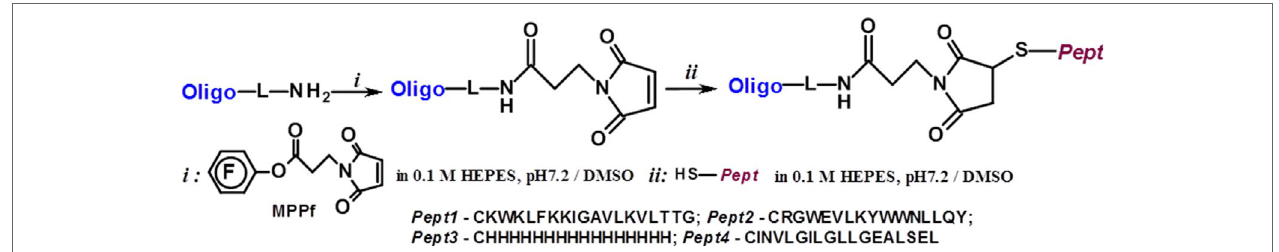
FIGURE 4 | Scheme of the synthesis of the peptide conjugates of modified oligonucleotides m-inh and pgd-inh